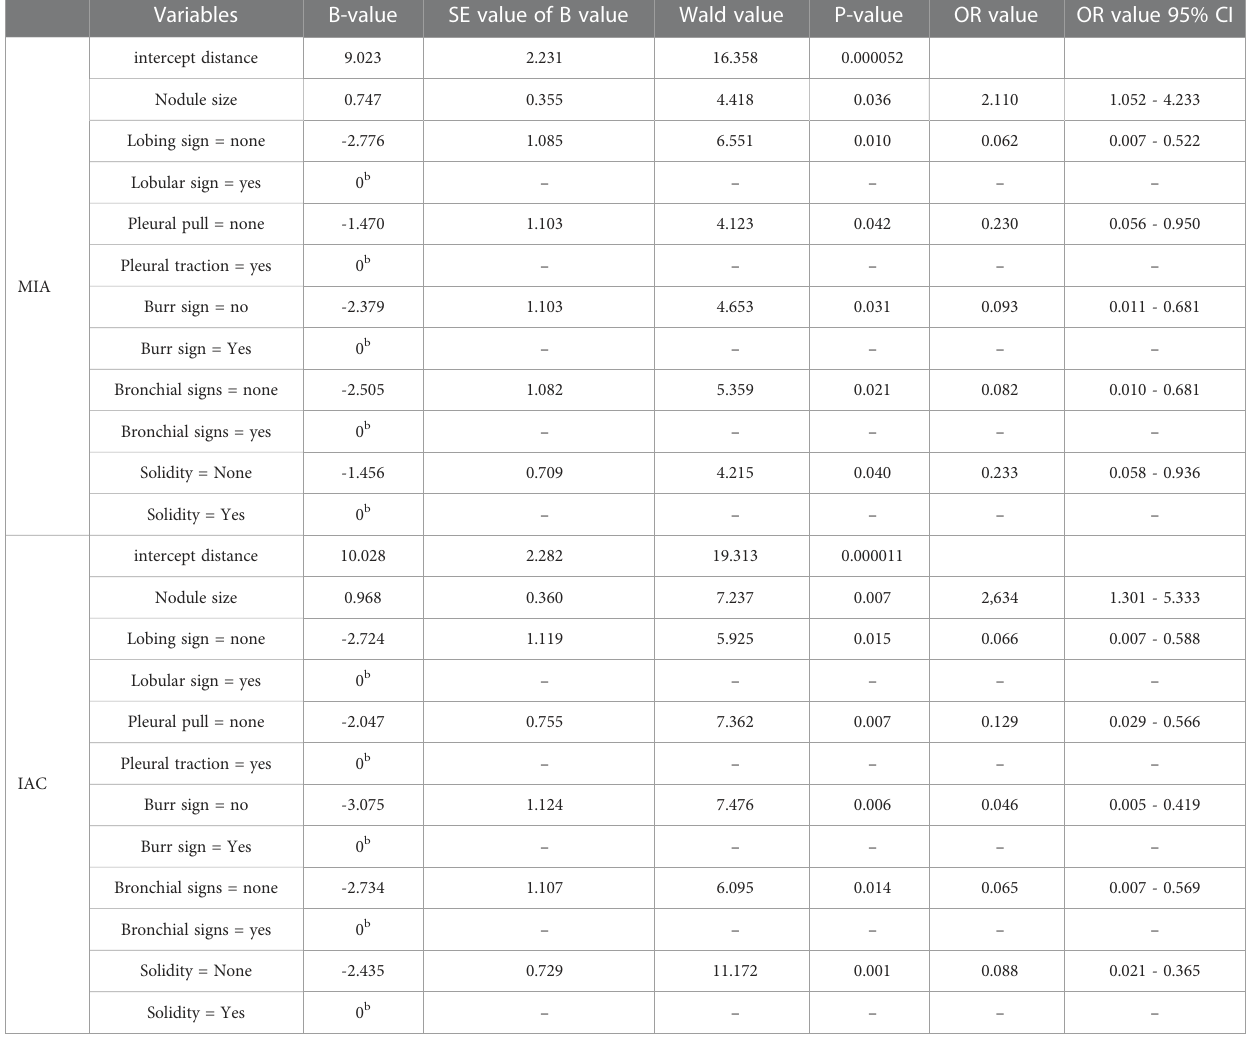
TABLE 2 Multiple logistic regression analysis of each CT sign and pathology